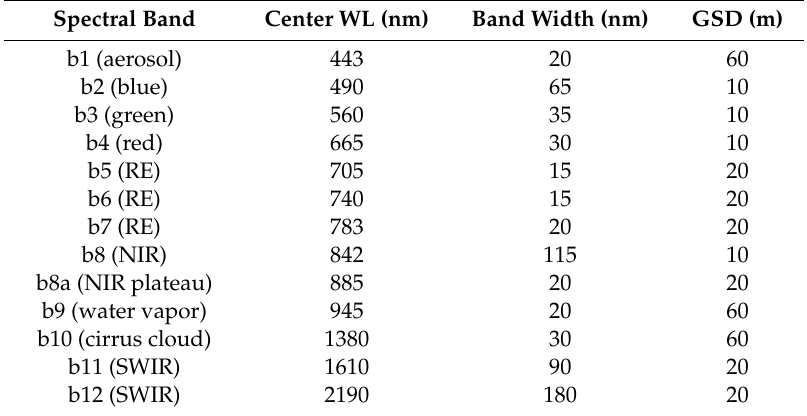
Table 1. S2 MSI (multi spectral instrument) data technical features (WL = wavelength; GDS = spatial resolution; RE = red edge, NIR = near infrared; SWIR = short wavelength infrared).